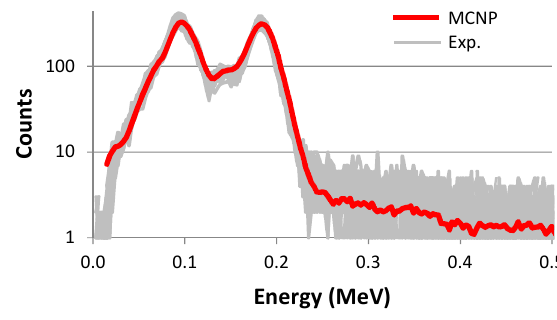
Fig.7. (cid:3) Comparison (cid:3) between (cid:3) 30 (cid:3) experimental (cid:3) and (cid:3) one (cid:3) simulated (cid:3) pulse (cid:3) height (cid:3) distributions (cid:3) from (cid:3) HEU (cid:3) source (cid:3) for (cid:3) 2s (cid:3) acquisition (cid:3)